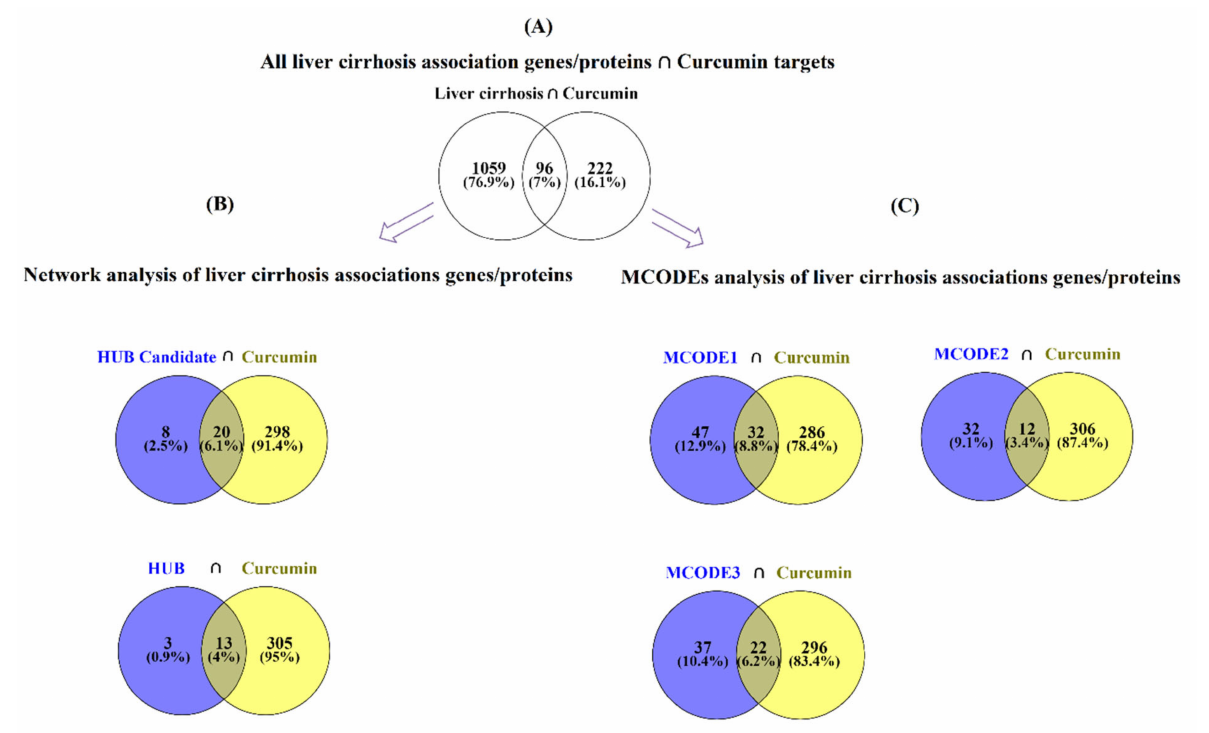
Figure 5. Intersection analysis of the curcumin targets and liver cirrhosis-related genes/proteins using a Venn diagram with ( A ) curcumin targets and all liver cirrhosis association genes, ( B ) curcumin targets and hub candidate/hub genes, ( C ) curcumin targets and MCODEs analysis of liver cirrhosis association genes/proteins.